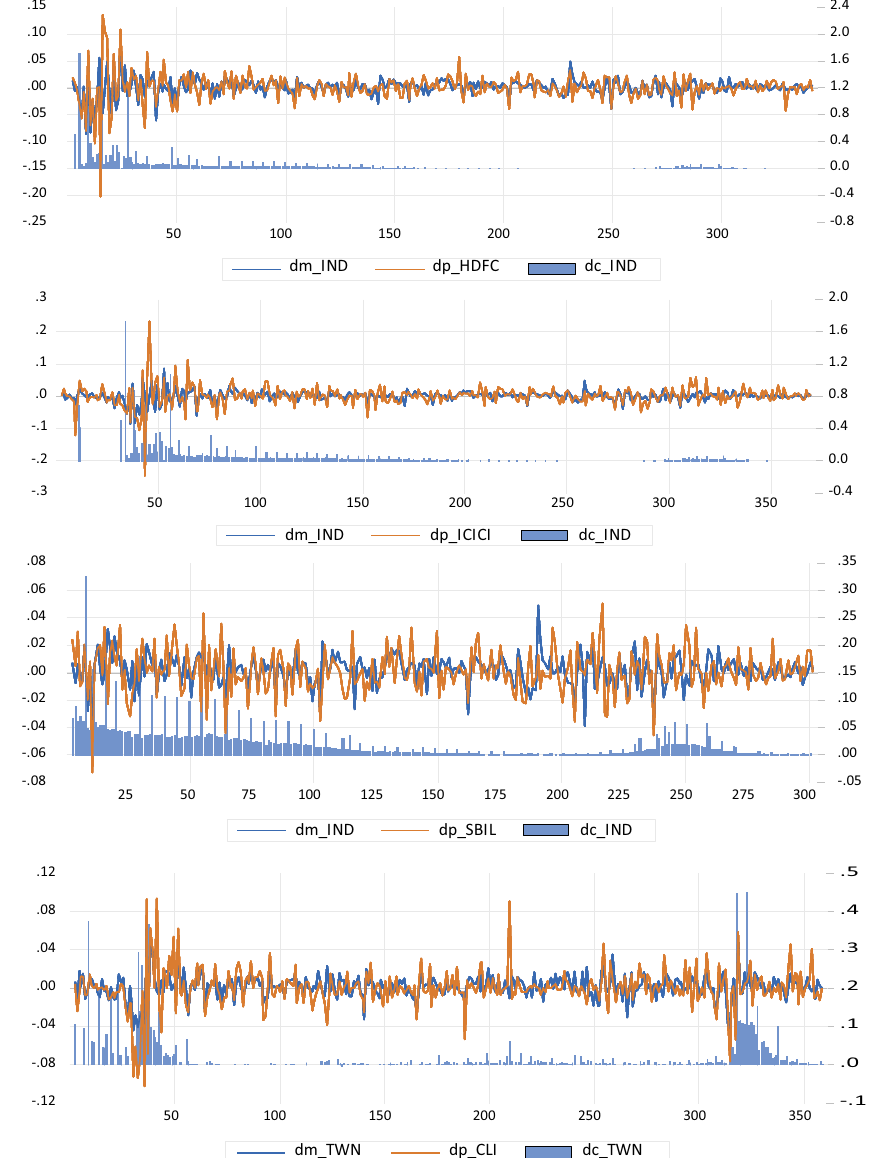
Fig. 1 The trends of market return ( dm ), futures return ( dp ) and growth rate of COVID‑19 ( dc ) in India and Taiwan (the left scale is the return rate, and the right scale is the confirmed growth